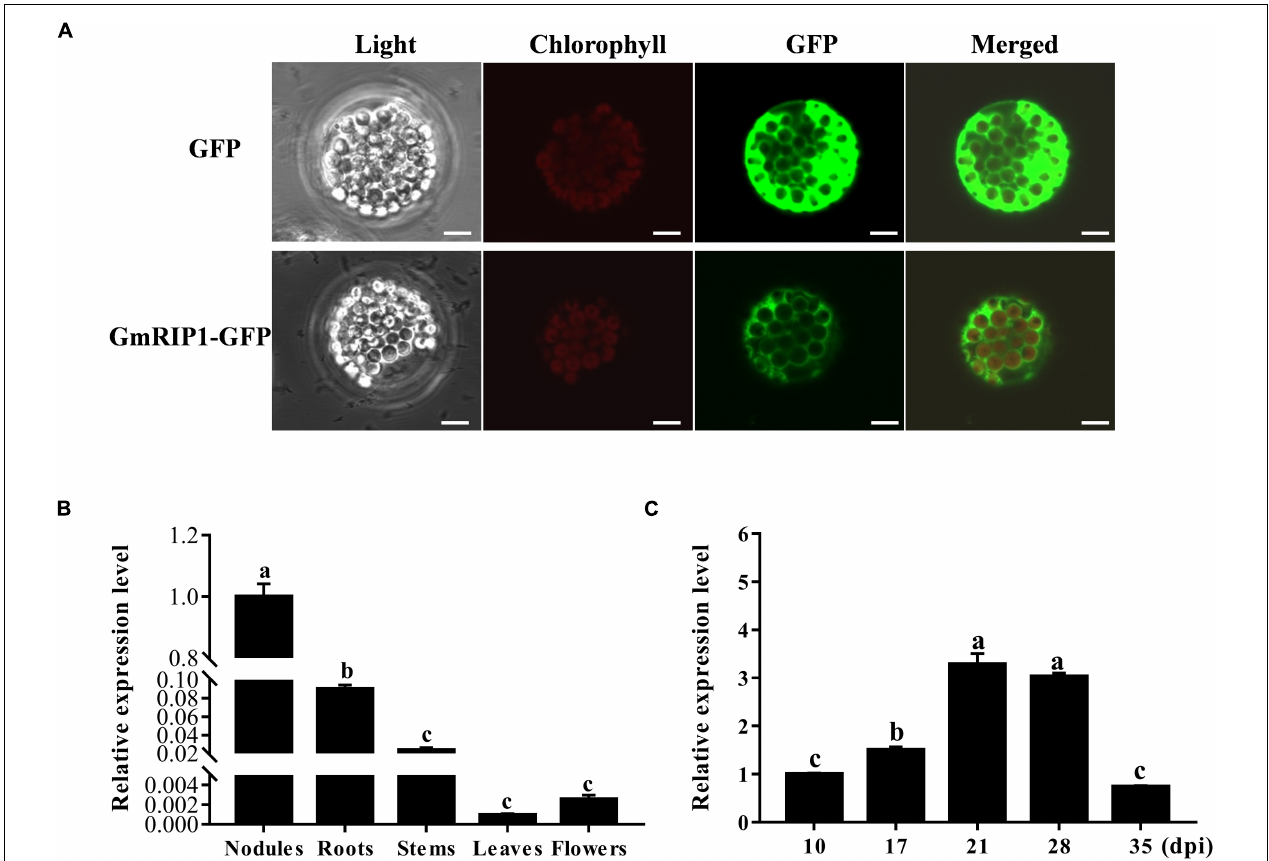
FIGURE 7 | Subcellular localization and expression analysis of GmRIP1. (A) Subcellular localization of GmRIP1 in protoplasts of Arabidopsis thaliana. The fluorescence of GmRIP1-GFP was observed in the cytoplasm of Arabidopsis protoplasts. The free GFP (empty vector) used as control was distributed in both nucleus and cytoplasm. GmRIP1-GFP: GmRIP1 was fused with GFP. Scale bars = 10 µ m. (B) Transcript accumulation of GmRIP1 in various organs of soybean. (C) Relative expression of GmRIP1 in nodules at different developmental stages. The relative expression value was normalized based on the expression of GmActin11 ( Glyma.18g290800 ) used as reference gene. Lowercase letters represent statistically significant differences ( p < 0.05) according to Tukey’s HSD test; all experiments were repeated at least three